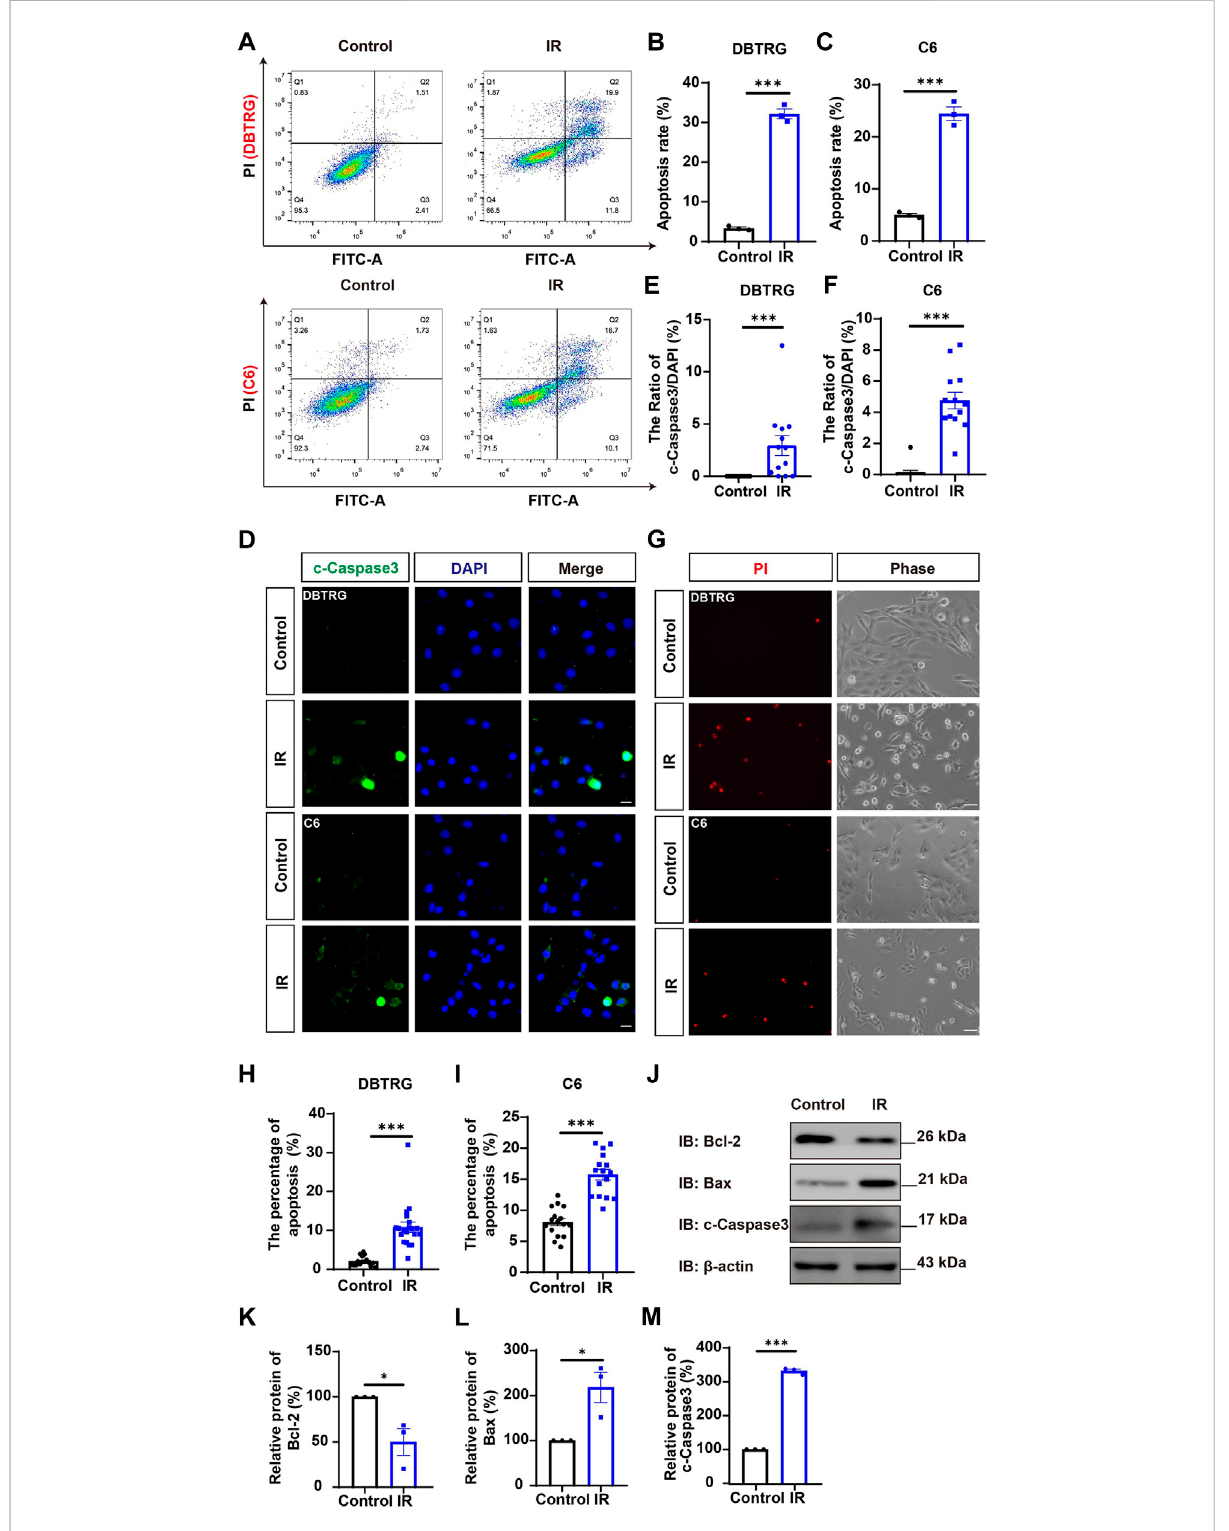
FIGURE 3 Irigenin induced the apoptosis of GBM cells. (A) Flow cytometry was performed to evaluate the apoptotic ratio in DBTRG and C6 cells treated with 50 μ M IR and the control. (B – C) Quanti fi cation of the percentage of apoptotic cells in DBTRG (B) and C6 cells (C) ( n = 3, per group).